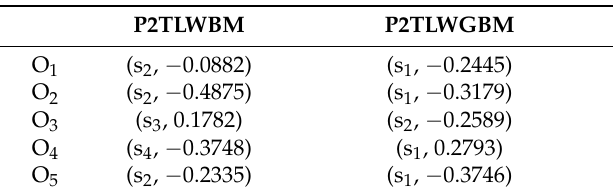
Table 3. The scores of the green suppliers.